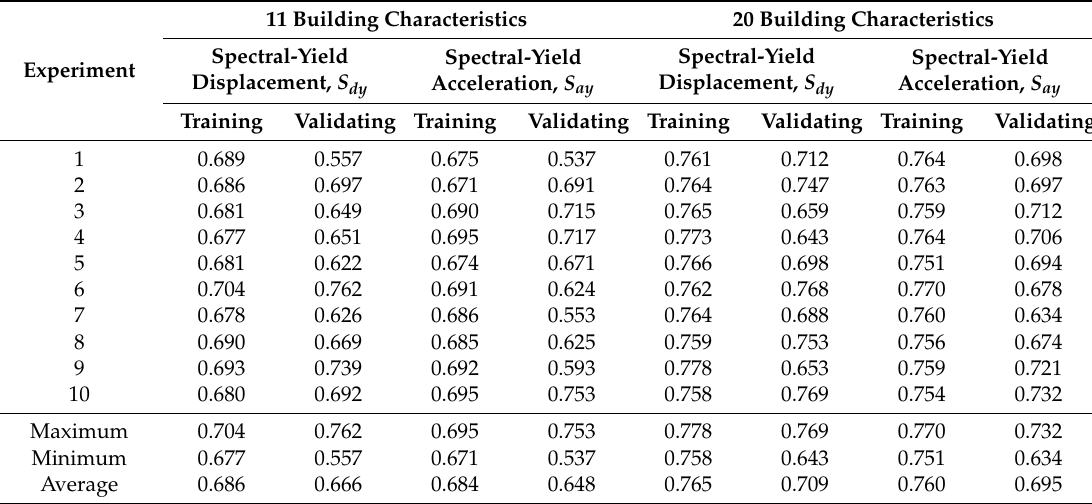
Table 4. Accuracy of 10-fold cross validation (training sample size of